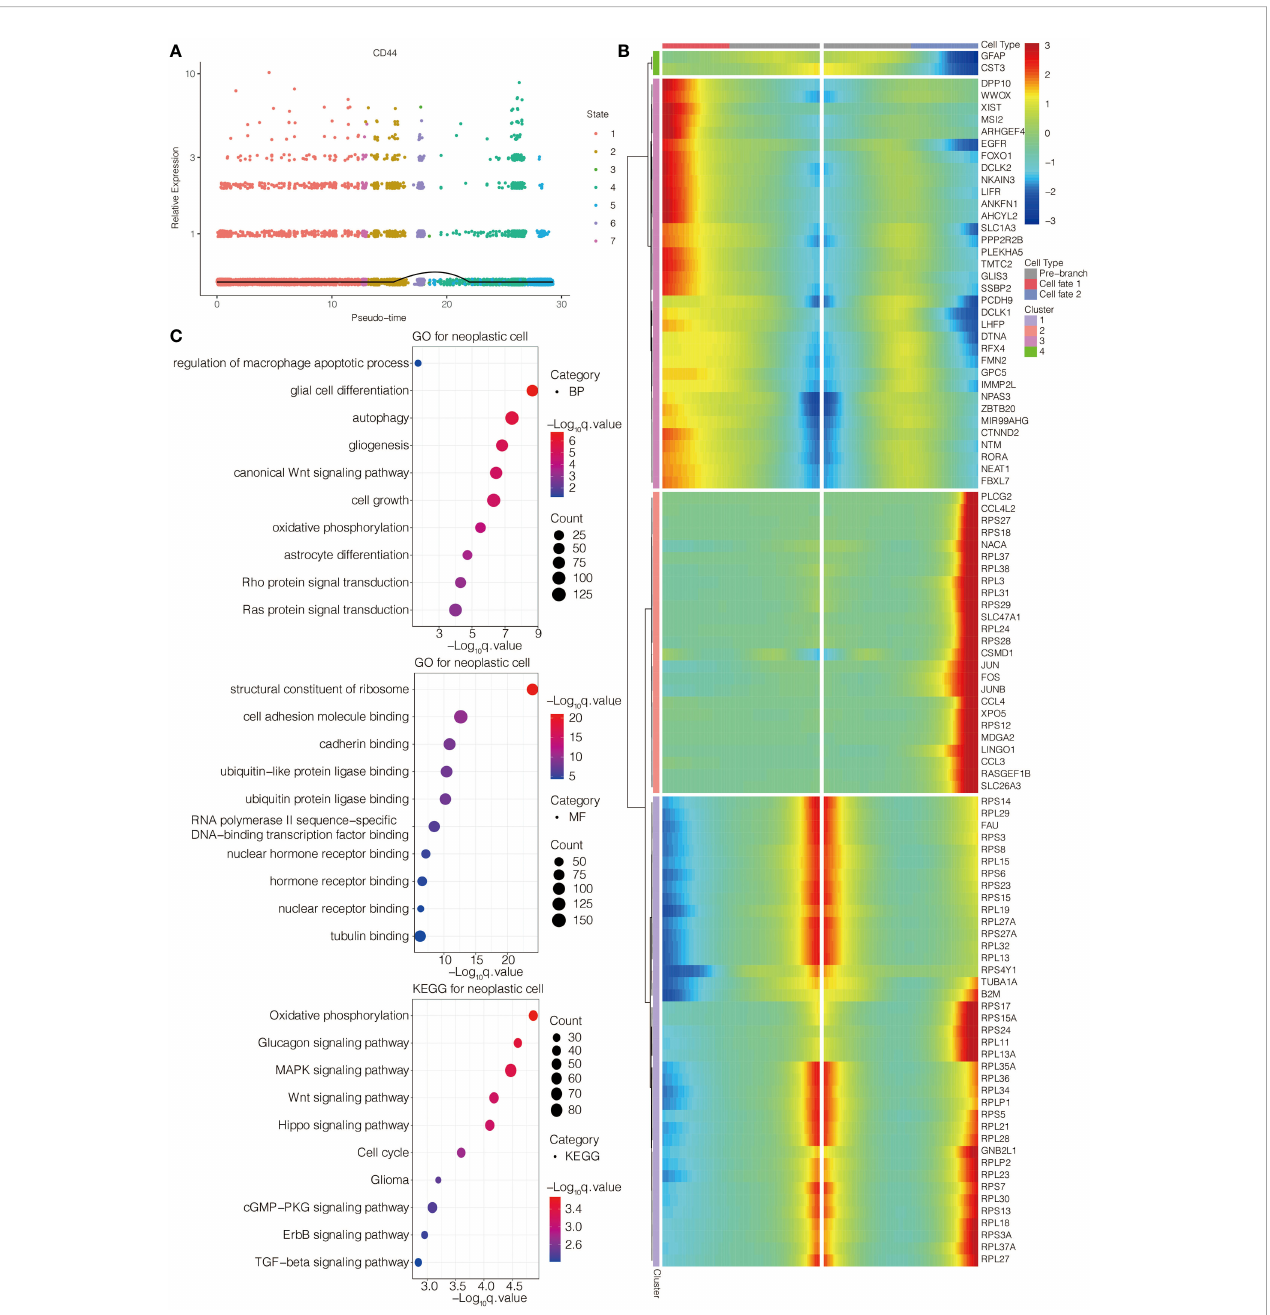
FIGURE 4 Function annotation of CD44 in glioma cells at the scRNA-seq level. (A) The expression level of CD44 regarding the pseudotime and cell state changes. (B) The gene expression pattern of 100 genes with branch-dependent expression for branch point 3. (C) GO and KEGG enrichment